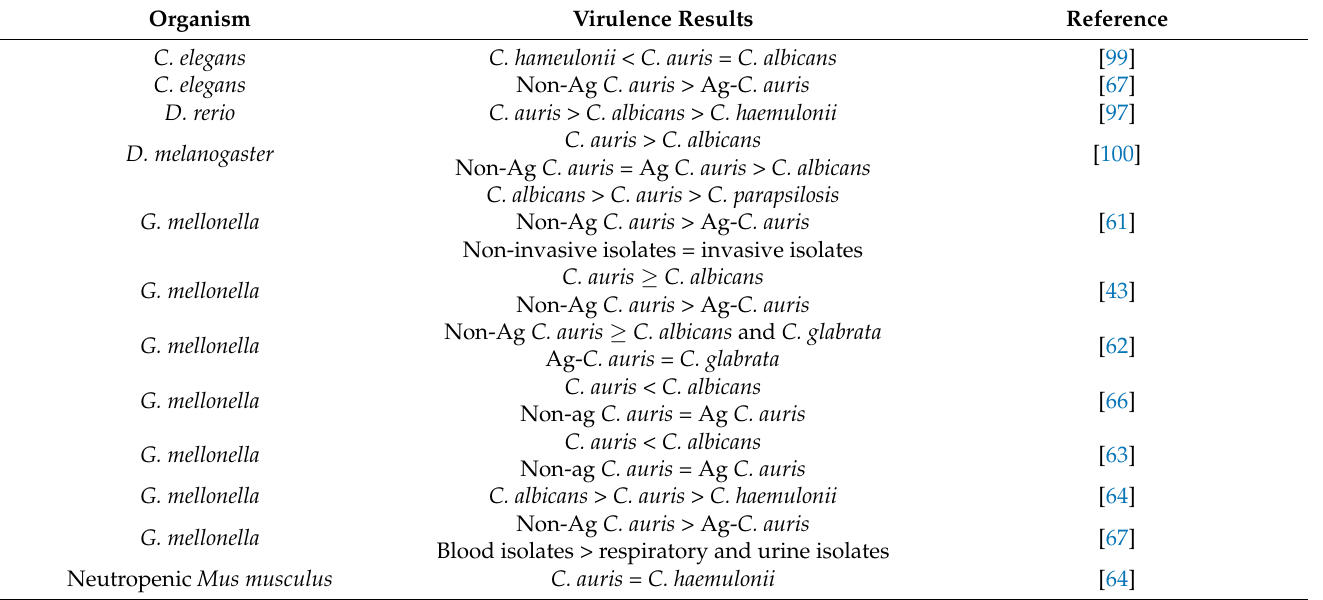
Table 1. Virulence of C. auris in different experimental animal